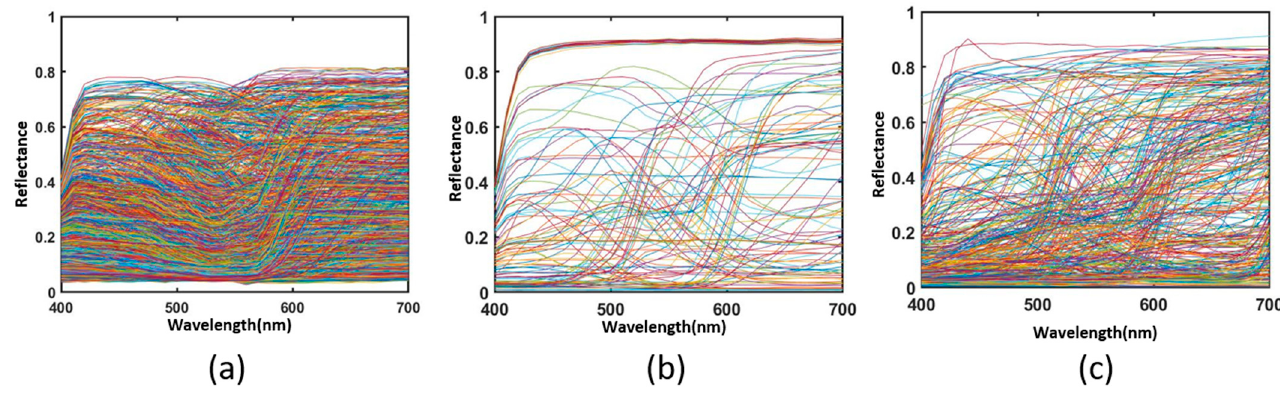
Figure 3. The spectral reflectance of ( a ) 1269 Munsell Matt chips, ( b ) the 140 ColorChecker SG and ( c ) the 354 Vrhel spectral dataset.